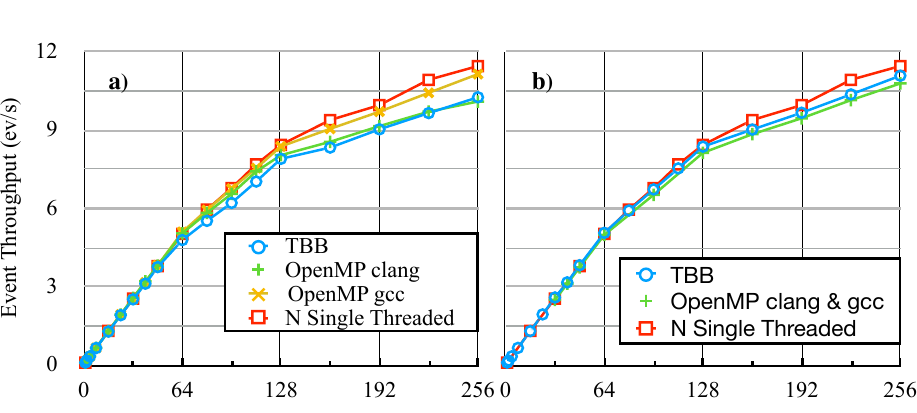
Fig. 4. Event throughput as a function of utilized cores where a) the OutputModule is serialized and uses internal parallelism with the possibility of task stealing and b) it is serialized and uses internal parallelism with task stealing prohibited. Both plots share the same Y